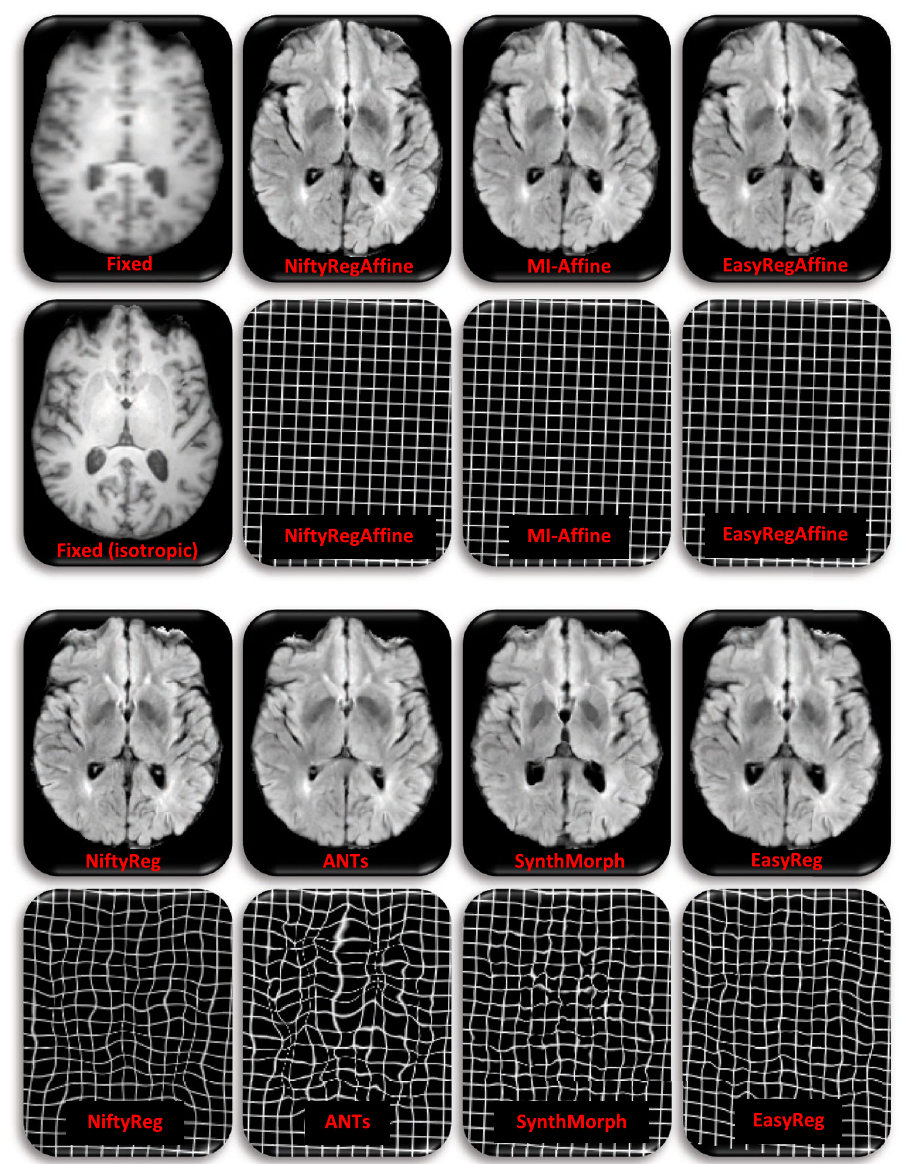
Figure 5. Sample registration from SagT1–AxFLAIR setup, i.e., 5 mm axial FLAIR from ADNI, to 5 mm sagittal T1-weighted scan from IXI. Top left: axial slice of the fixed image and corresponding isotropic slice; the later was not used in registration; we display it for easier qualitative assessment of registration accuracy. Rest: corresponding registered slice and deformation field (represented as a deformed grid) for the seven competing